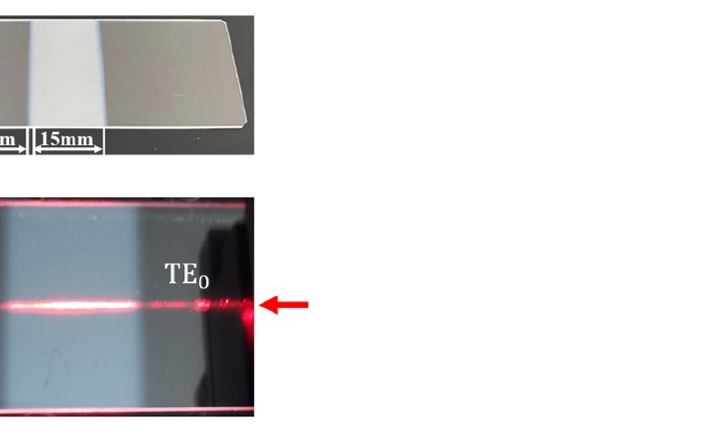
Figure 5. Photographs of the COWG with a tapered Ta 2 O 5 layer: ( a ) the freshly fabricated COWG; ( b ) the COWG with a scattered light streak along the propagation path of the TE 0 mode.